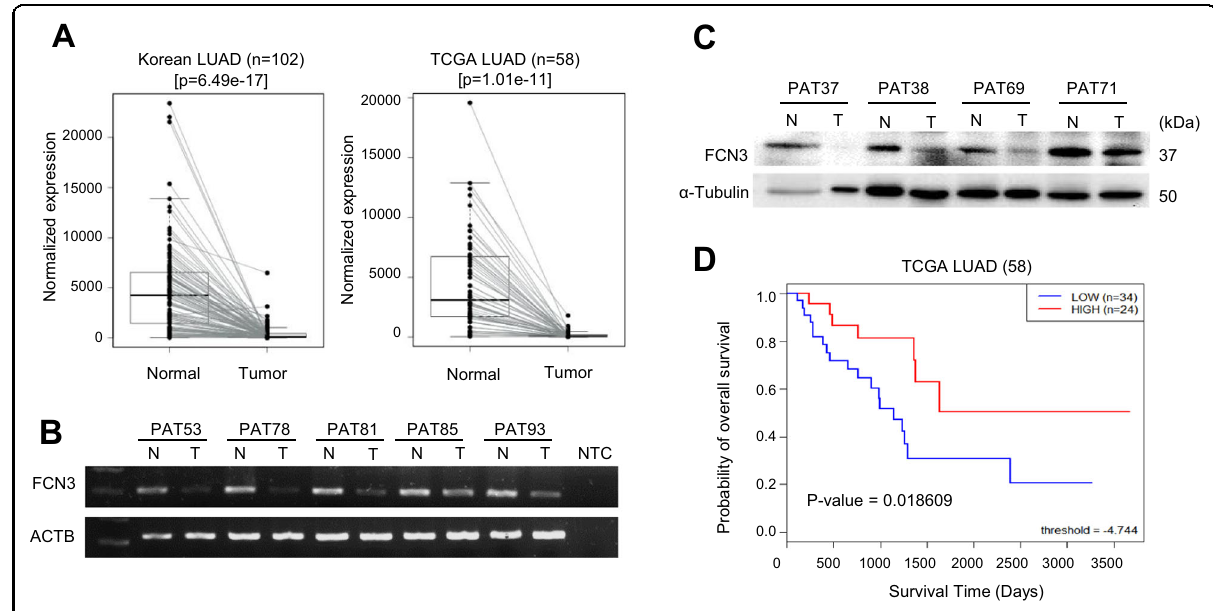
Fig. 1 FCN3 is down-regulated in LUAD. A Box-plots of FCN3 RNA expression in normal-tumor matched 102 LUAD patients in this study (left panel) and of normal-tumor matched 58 patients from TCGA data (right panel). The bold line in the middle of each box represents the median level. B Conventional RT-PCR con fi rmation using normal (N) and tumor (T) tissue samples from 5 representative LUAD patients. ACTB was used as an endogenous reference gene. Note that mRNA expression of FCN3 is markedly down-regulated in tumor tissues. NTC stands for no template control. C Immunoblot analysis of FCN3 expression in normal (N) and tumor (T) tissue samples of 4 representative patients. ɑ – Tubulin was used as the loading control. FCN3 down-regulation is con fi rmed. D Kaplan – Meier survival curves of 58 TCGA LUAD patients divided into two groups based on FCN3 expression. Long-term survival was seen to be signi fi cantly correlated with high expression of FCN3